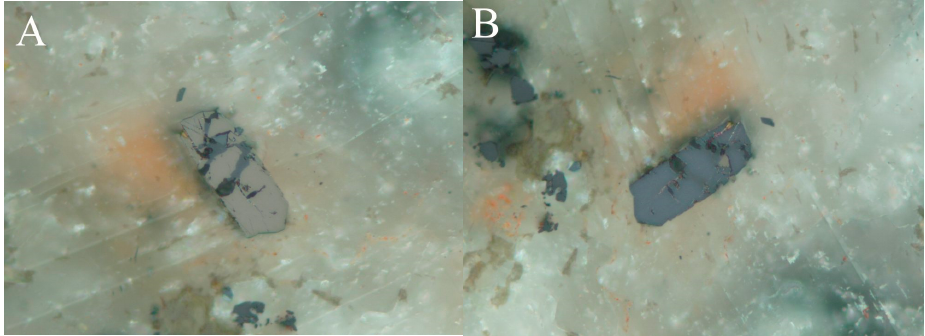
Figure 37. Pinkish ferroselite anhedral grain with very intensive anisotropism ( A , B ). Reflected light, partly-crossed polarizers. FOV 210 μ m. P ř íbram, a dump of shaft 16. Photo by P. Škácha.